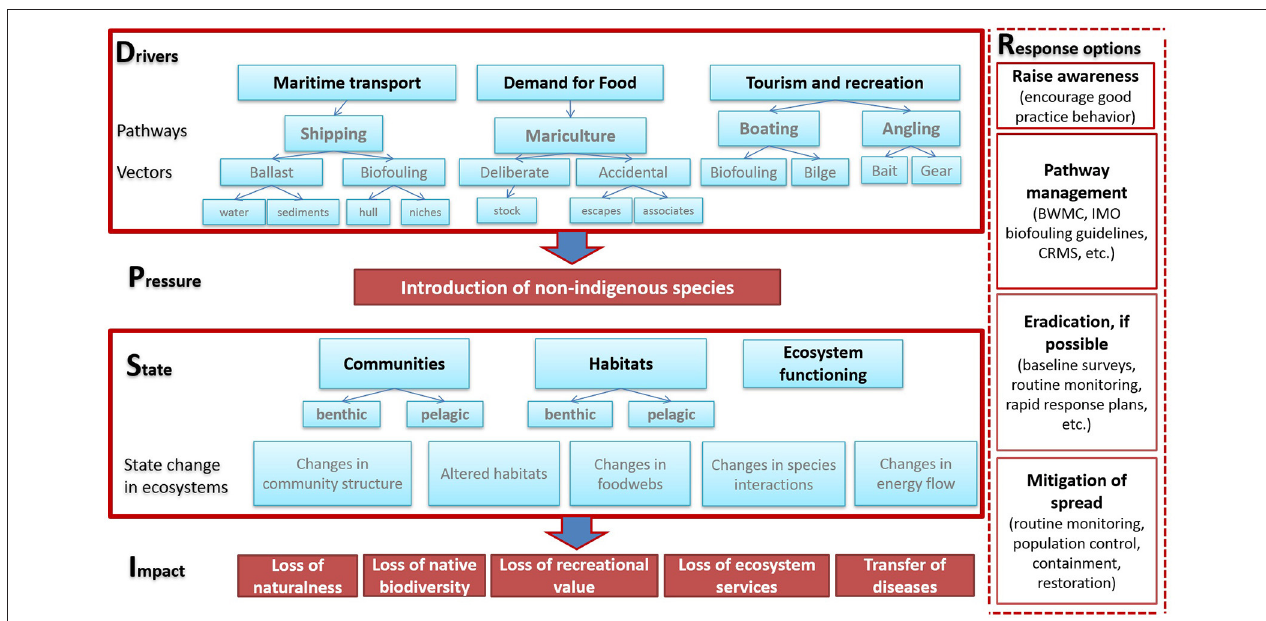
FIGURE 1 | Available response and management measures to non-indigenous species introductions, separated across different levels of an ecosystem based management (driver-pressure-state-impact-response) framework (based on Oesterwind et al.,